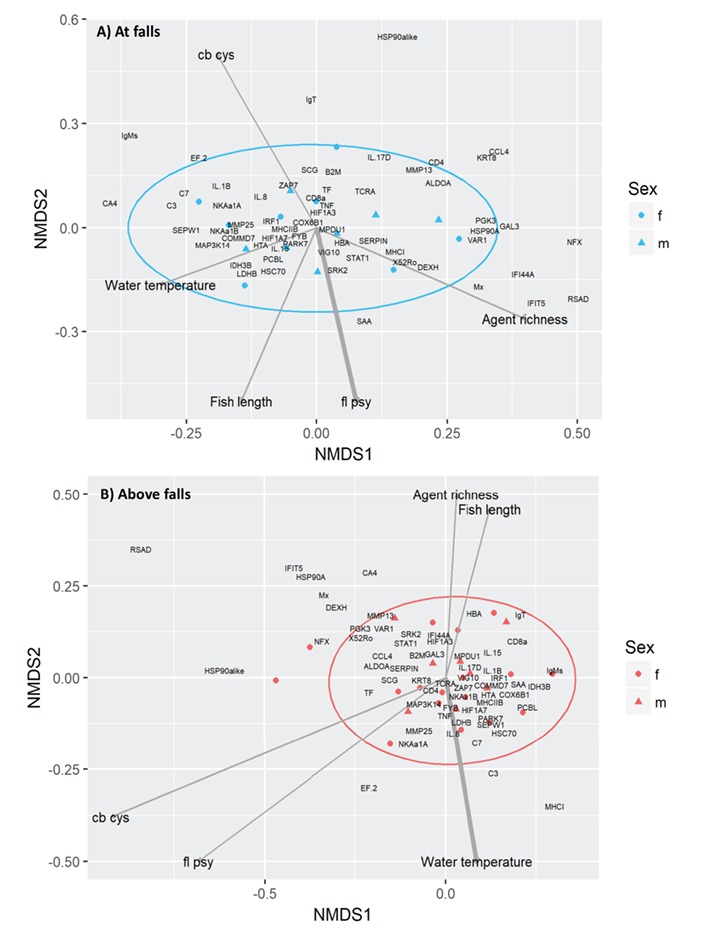
NMDS plots of host gene expression in the gill tissues of Bulkley River steelhead (n = 40) caught (A) at Witset Falls and (B) above Witset Falls. The shape of each point reflects sex (circle reflects female; triangle, male). Vectors represent external variables fit into the ordination including the relative loads of Ca. B. cysticola and F. psychrophilum, agent richness, water temperature and FL. Bolded lines indicate significant vectors. Confidence ellipses (95%) are shown in blue and red. In plot (A) the most influential variables on NMDS1 are RSAD (5.0%), NFX (4.9%) and IFIT5 (4.2%) and on NMDS2 are HSP90alike (8.6%), IgT (5.8%) and SAA (4.2%). In plot (B) the most influential variables on NMDS1 are RSAD (8.6%), HSP90alike (6.2%) and IFIT5 (4.3%) and on NMDS2 are RSAD (8.6%), MHCI (3.1%) and IFIT5 (4.3%).